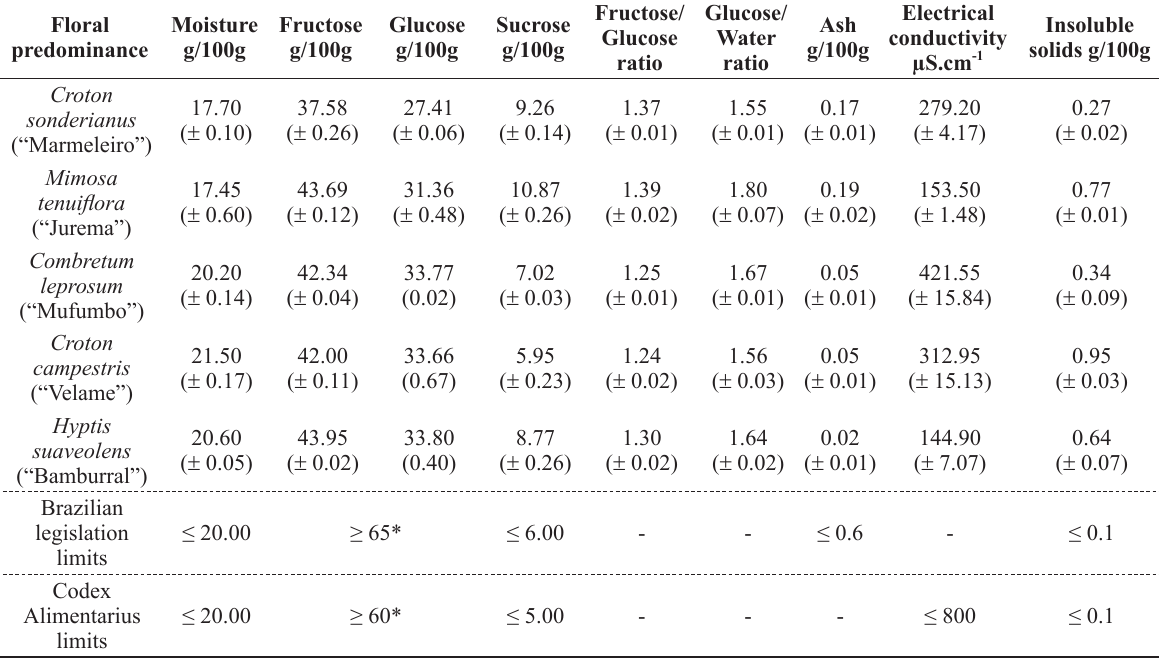
Physicochemical characteristics of